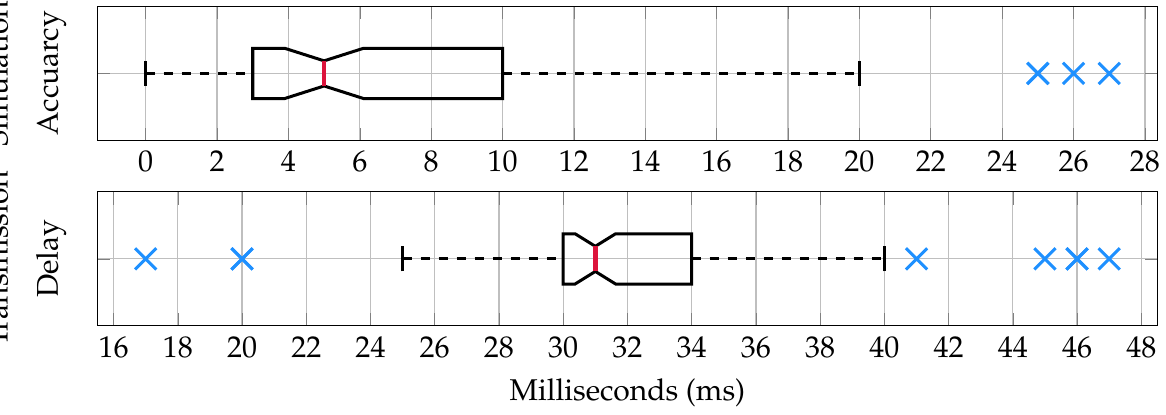
Figure 24. Time delays of the simulation environment and the message transmission during a benchmark with 100 iterations.